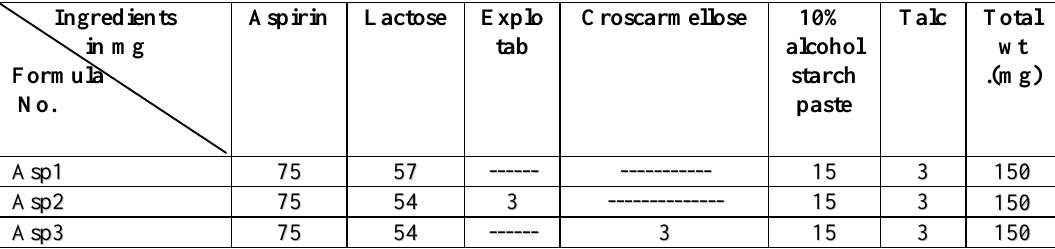
Table 1: Different formulas of aspirin immediate release layer.